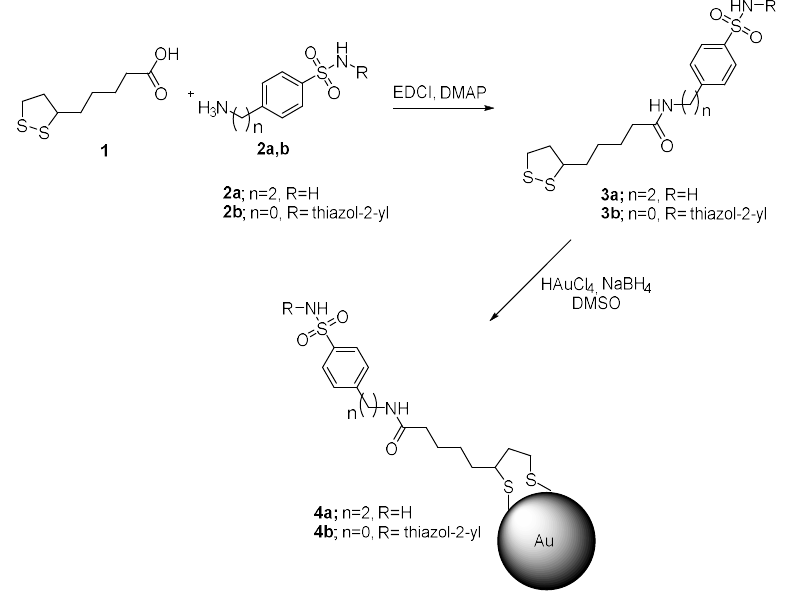
Table 1. CA inhibition data against intermediates 3a and 3b coated nanoparticles 4a and 4b and Au shell against the hCAs I, II, and IX in comparison with the standard CAI AAZ . Data in parentheses refer to the K I values after 2 h of incubation